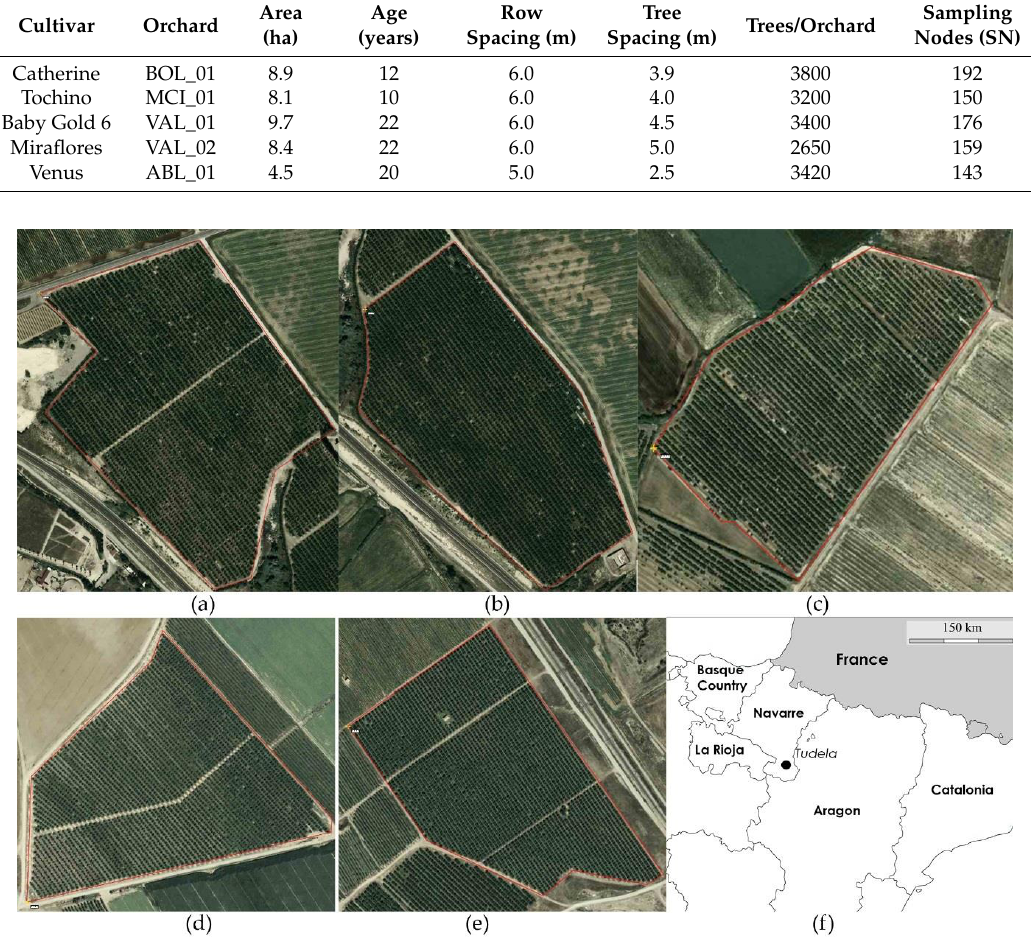
Figure 1. Cadaster images and location of the orchards used in the study. ( a ) VAL_01; ( b ) VAL_02; ( c ) ABL_01; ( d ) MCI_01; ( e ) BOL_01; ( f ) Location of the study area, indicated by a black